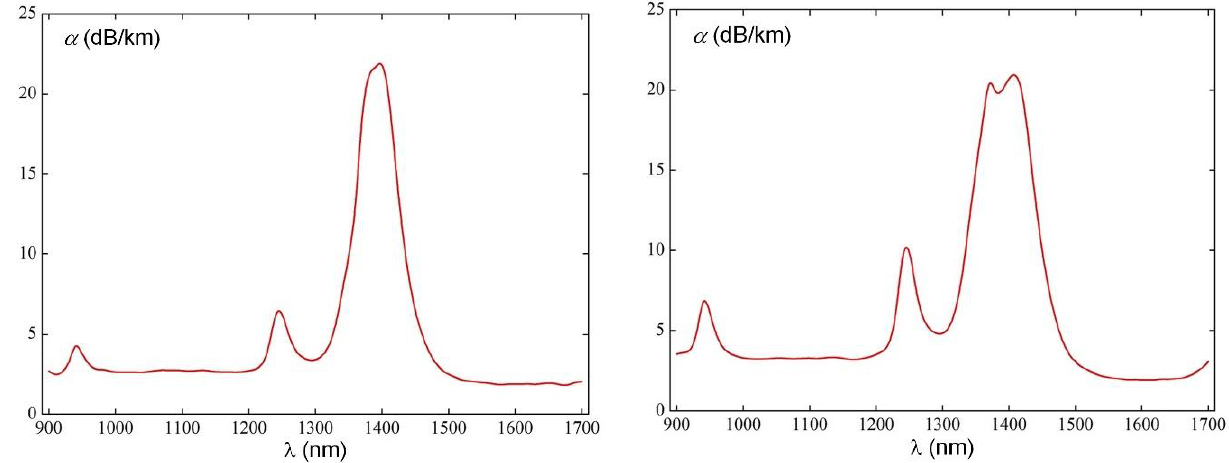
Figure 6. Attenuation of manufactured ESSR-MOF samples with induced chirality: ( a ) 10 revolutions per meter; ( b ) 66 revolutions per meter.